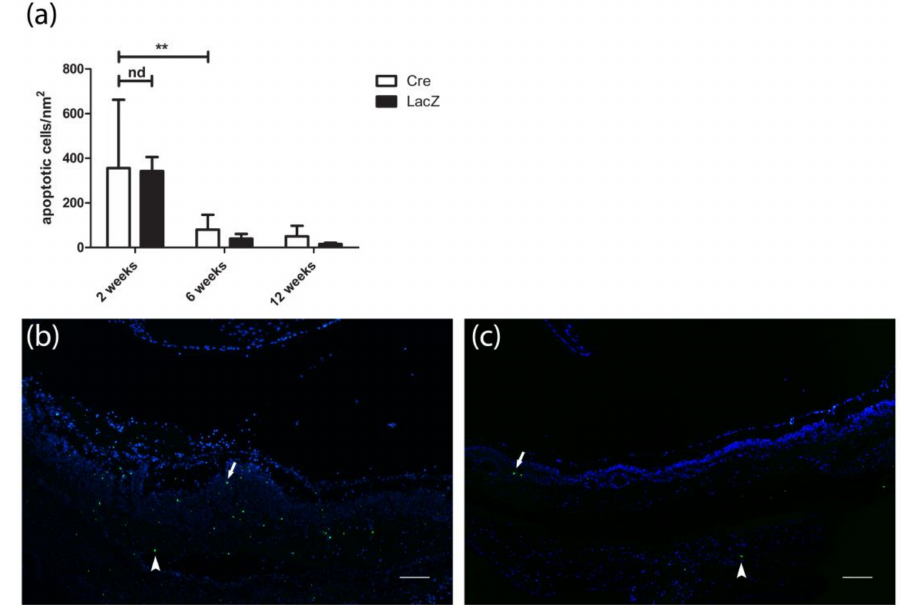
Figure 6. Apoptosis in the retina after subretinal injection in terminal deoxynucleotidyl transferase dUTP nick end labeling (TUNEL) staining (green) with DAPI nuclear counterstain